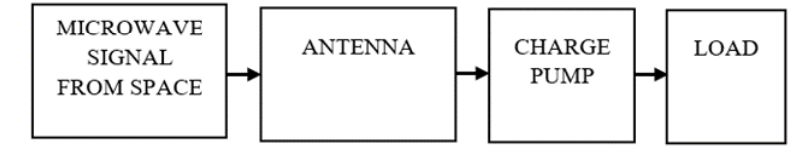
Figure 1. General system